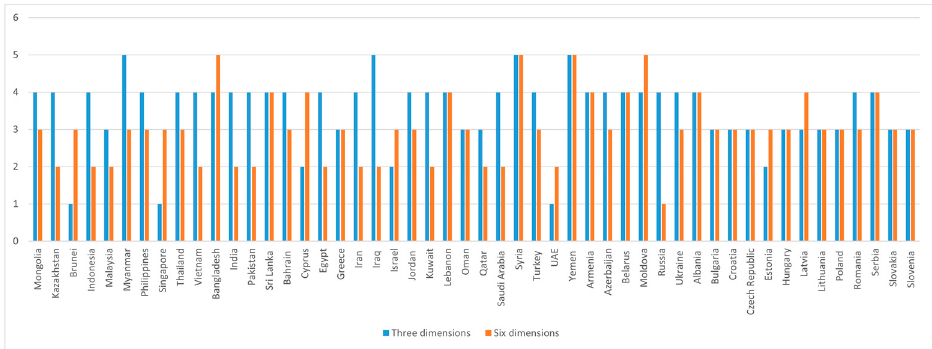
Figure 6. The investment risk results of the integrated evaluation of mineral resources.